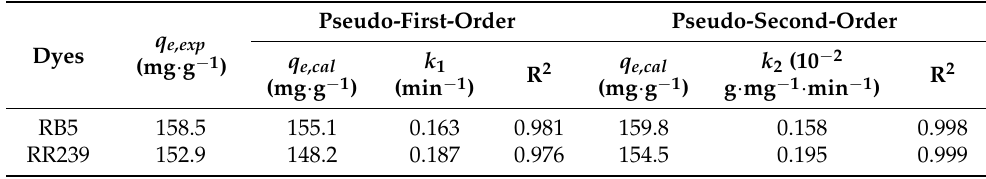
Table 2. The adsorption kinetics parameters of CM-ATP.